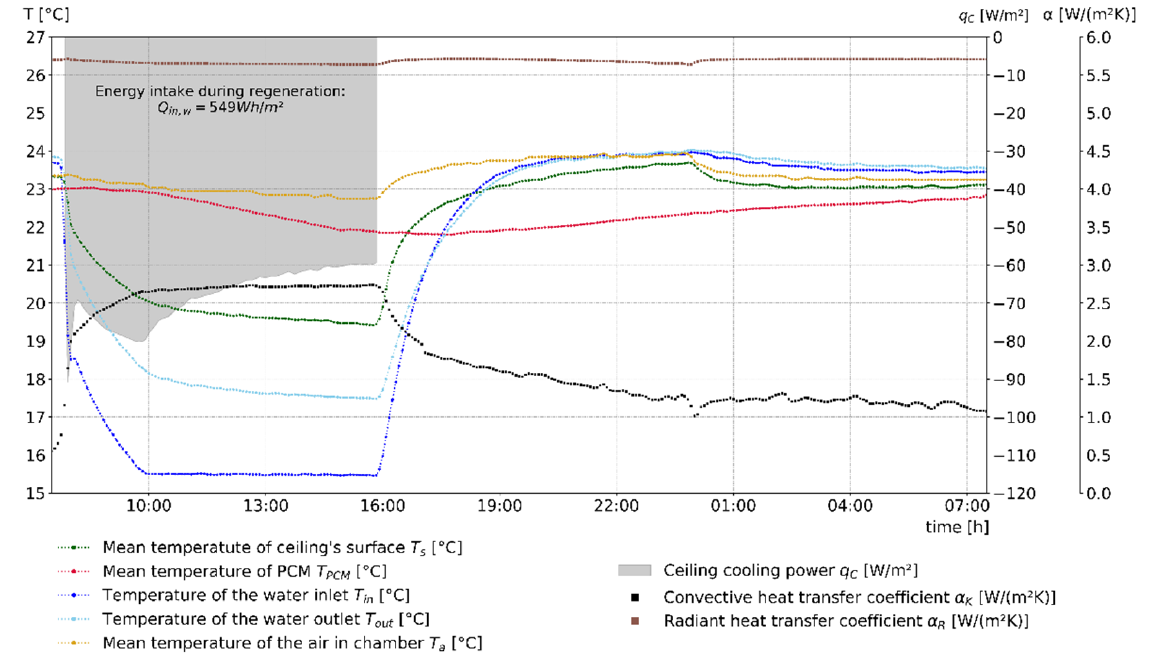
Figure 6. Experimental results for variant Ia.